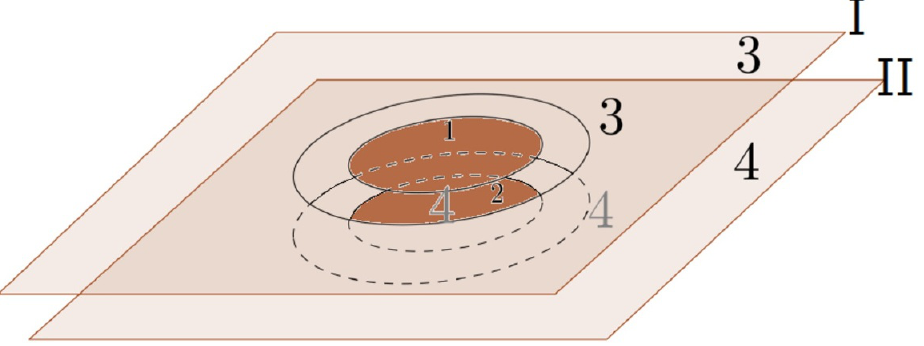
Figure 23 . The two lines structure. Layer (cid:12)rst one is denoted I while the second is II. These two layers are